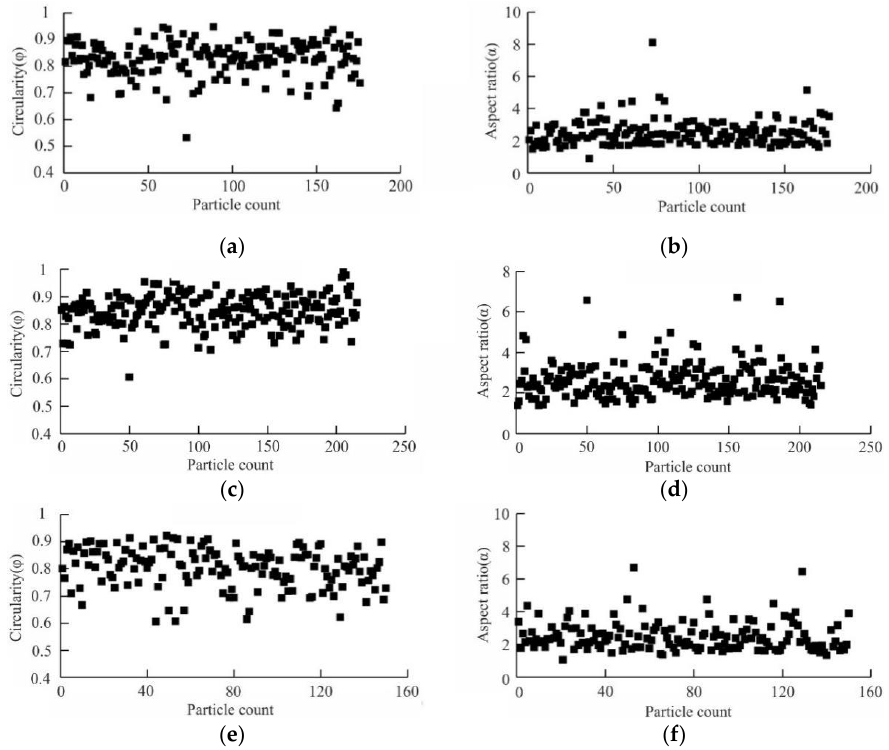
Figure 16. Particle shape statistics of glacial till samples: ( a ) X-section circularity statistics; ( b ) X-section aspect ratio statistics; ( c ) Y-section circularity statistics; ( d ) Y-section aspect ratio statistics; ( e ) Z-section circularity statistics; ( f ) Z-section aspect ratio statistics.